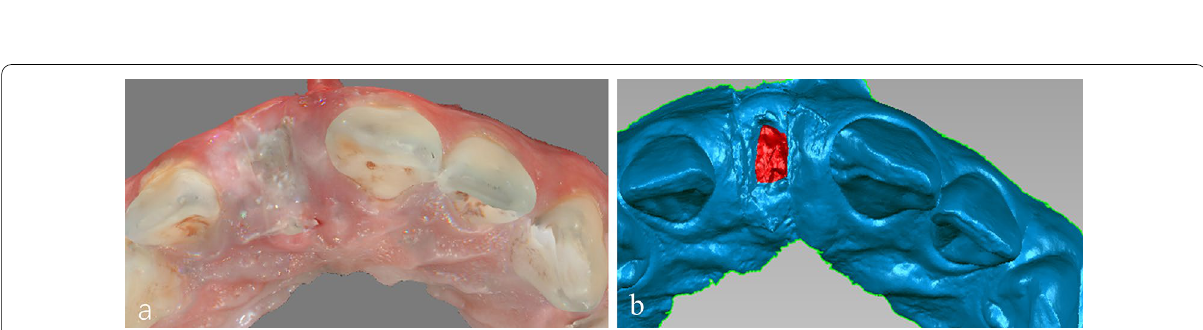
Fig. 2 The representative pictures of intraoral scanner. a Wounds are recorded using oral scanning software; b the area identified for assessment of area changes is demarcated in